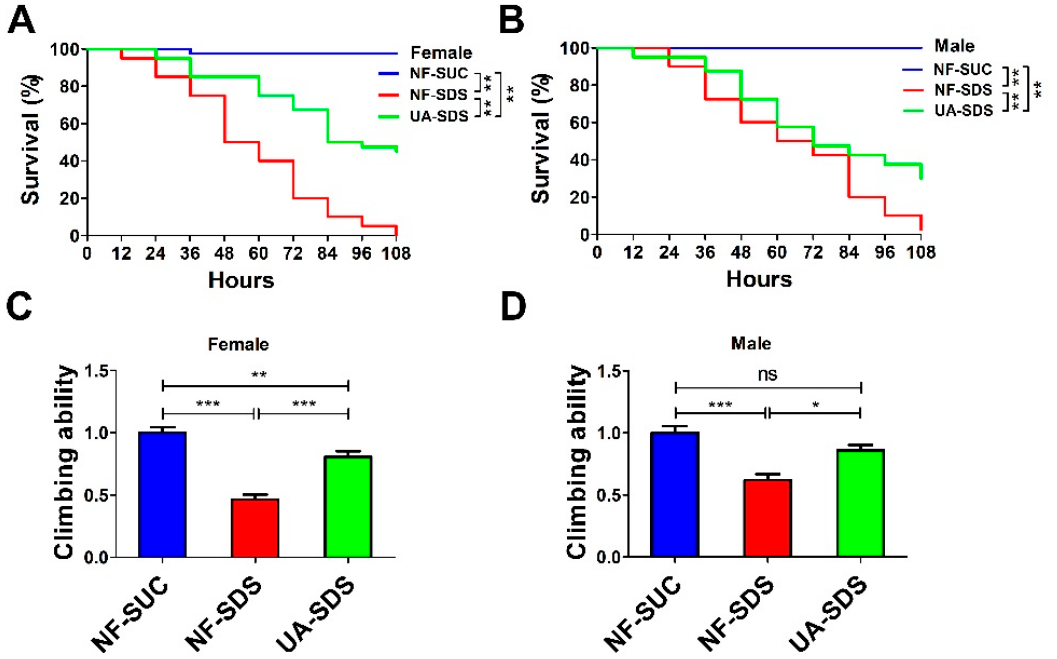
Figure 1. The reduced survival rate and climbing ability caused by sodium dodecyl sulfate (SDS) could be improved by ulcerative colitis (UA) in Drosophila . ( A , B ) The ulcerative colitis (UC) model group (NF-SDS) showed shorter life span than control group (NF-SUC). The 100 µ M UA supple- mentation (UA-SDS) can significantly elevate the decreased survival rates of both female ( A ) and male ( B ) flies exposed to 0.5% SDS (NF-SDS). ( C , D ) The UC model group (NF-SDS) showed de- creased climbing ability compared to the control group (NF-SUC). UA supplementation (UA-SDS) elevated the reduced climbing ability of female ( C ) and male ( D ) flies treated with 0.5% SDS. * p < 0.05, ** p < 0.01, *** p < 0.001, ns: not significant.